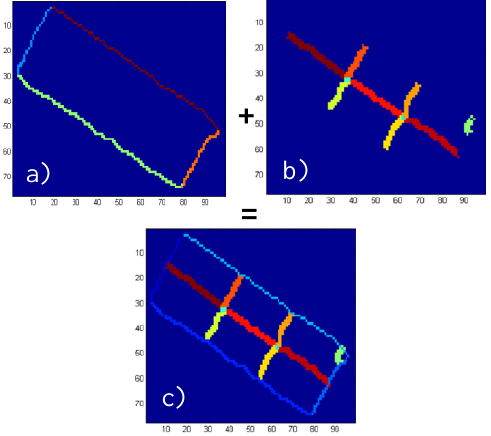
Figure 3. a) Visualisation of the building outer boundaries matrix; b) raster_inner_boundaries matrix; c)